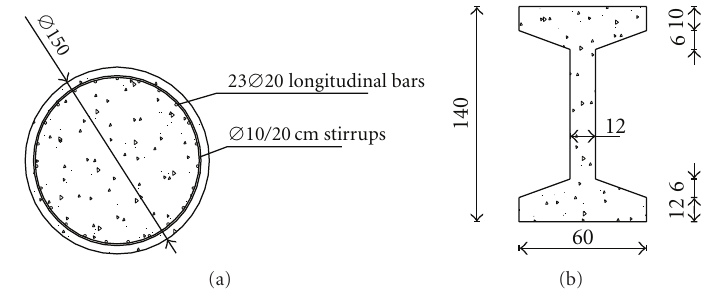
Figure 4: Cross sections of (a) typical column with reinforcement and (b) typical longitudinal precast concrete beam.